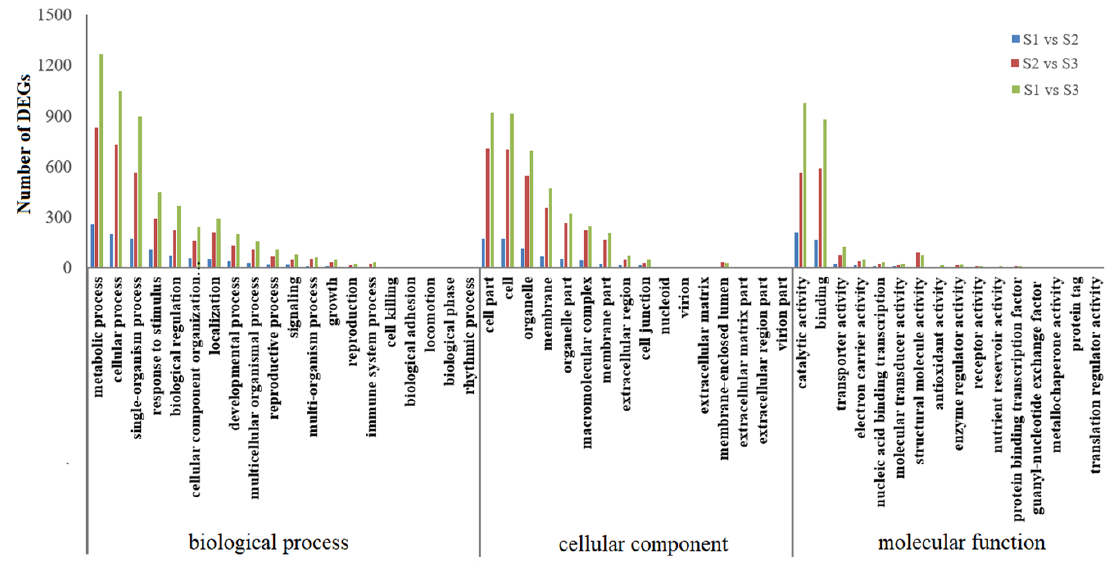
Figure 3. GO enrichment of identified DEGs in developing common buckwheat seeds. S3. S1, S2, and